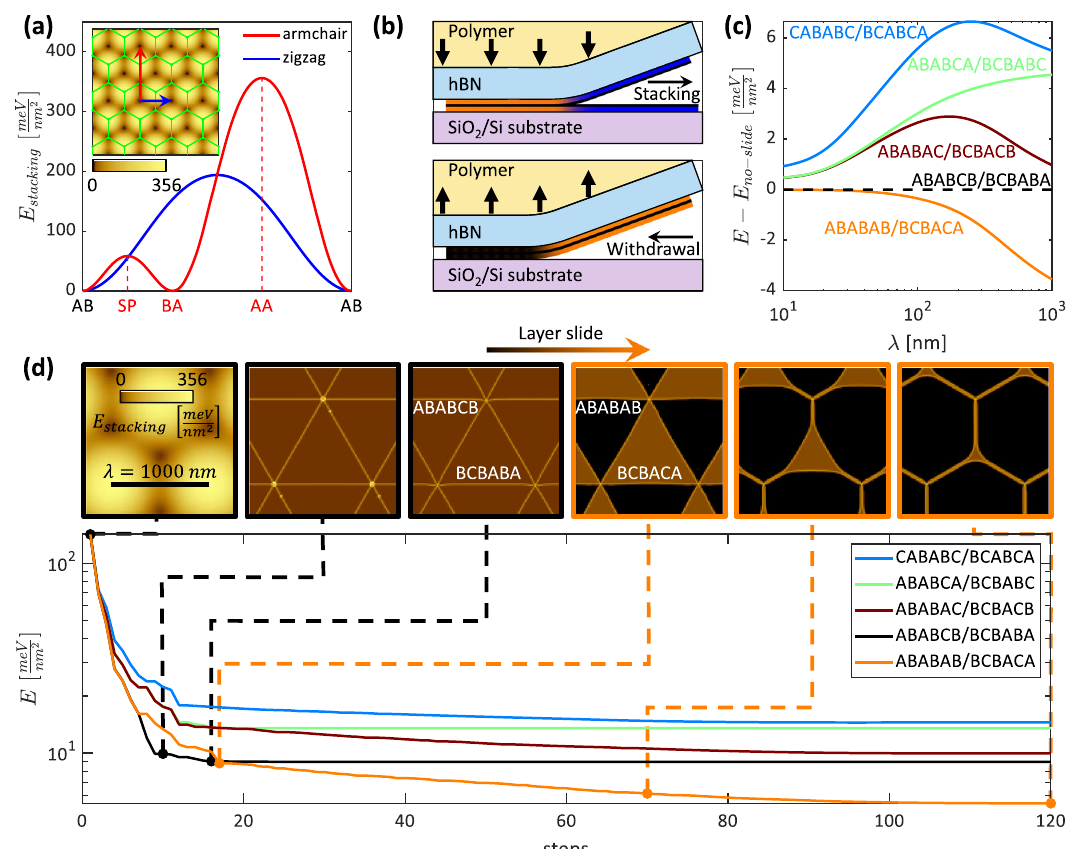
Fig. 4 | Energy analysis for atomic relaxation driven formation of unstable phases by sliding layers. a Stacking energy density at the interface between two graphene sheets for different con fi gurations. The plot presents cuts along the zigzag and armchair directions. Inset: Stacking energy density in the two- dimensional con fi guration-space re fl ecting the stacking energy density as a func- tion of translation of one sheet relative to the other (green honeycomb lattice). b Scenarios for generation of a new phase during stacking. Top: New phase (orange) generation during contact of the two TLGs (blue). Bottom: New phase generation (orange) asthe TDTGstack is picked up from the surface. c Comparing total energy density as a function of moiré periodicity for different relaxed